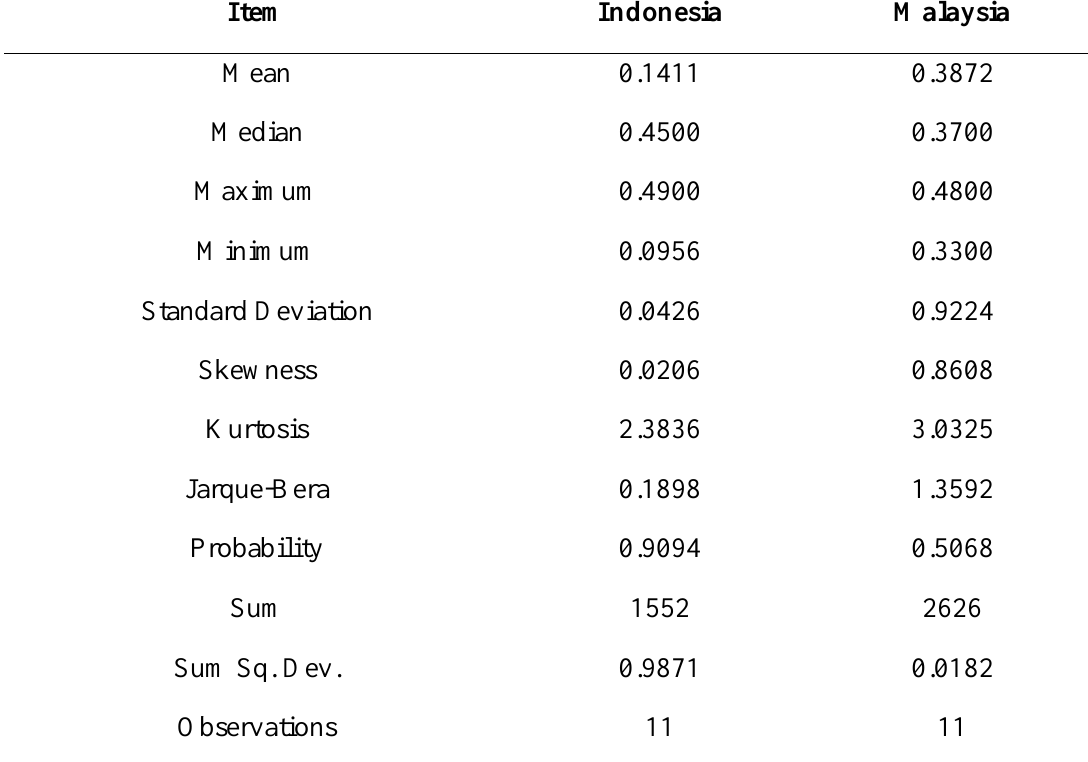
Table 3. Descriptive Statistic (Logarithmic Returns) of Indonesia and Malaysia